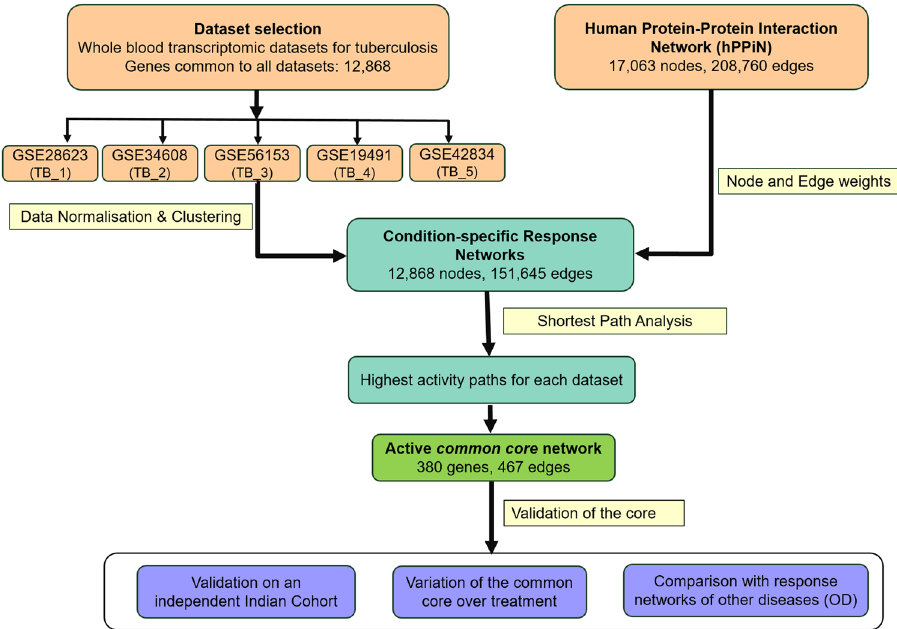
Fig. 1 Work fl ow adopted in this study. Whole blood transcriptomic pro fi les from tuberculosis patients and corresponding healthy controls were normalised and integrated into a curated human Protein – Protein Interaction Network (hPPiN) to generate condition-speci fi c networks, from which highest activity ‘ response networks ’ were identi fi ed. A comparison of these networks led to the identi fi cation of a common core highly active in disease. The signi fi cance of this common core was assessed on an independent microarray dataset generated for the Indian Cohort, and its speci fi city to tuberculosis was determined by monitoring its variation over treatment as well as by comparing similar response networks generated for other in fl ammatory diseases Sarcoidosis, Pneumonia, Still ’ s disease and SLE, collectively termed as OD